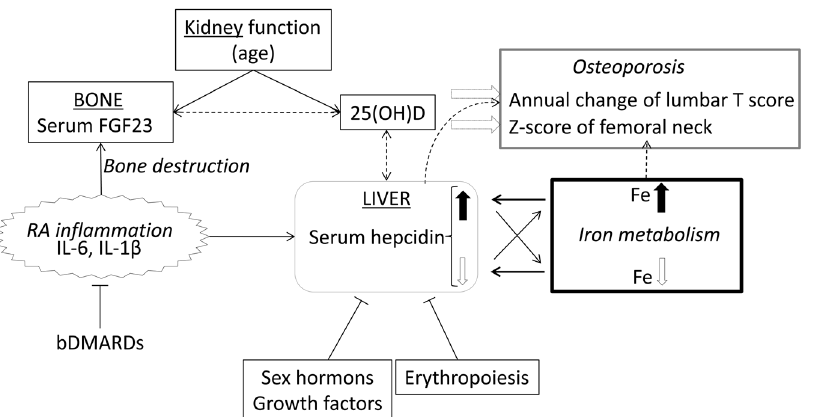
Figure 4. Estimated relationships related to hepcidin in patients with RA. Hepcidin is usually regulated by iron metabolism—iron overload (black arrow) leads to an increase in hepcidin, and iron deficiency (white arrow) leads to a decrease—and is suppressed by erythropoiesis, sex hormones, and growth factors. To maintain iron homeostasis, higher hepcidin levels result in a decrease in serum iron levels, while lower hepcidin levels increase serum iron levels. When inflammation due to RA occurs, production of hepcidin is increased through inflammatory cytokines that cause elevated ferritin levels. In this study, serum iron levels are positively related to serum hepcidin and ferritin levels but negatively related to inflammation due to RA. This unexpected relationship may give arisen because inflammation in most of the patients was well-controlled. Although iron overload and hepcidin may influence osteoporosis, in this study serum iron level was positively related to BMD but serum hepcidin level was not. However, serum 25(OH)D level was positively related to the serum hepcidin level and also positively related to the femoral Z score in this study. According to previous reports, opposite effects of serum iron level on BMD and 25(OH)D on hepcidin are indicated, and further research is needed to determine the mechanism. Serum FGF23 is not directly related to the serum hepcidin level, but serum 25(OH) D level and inflammation are common factors involved in the regulation of both serum hepcidin and FGF23